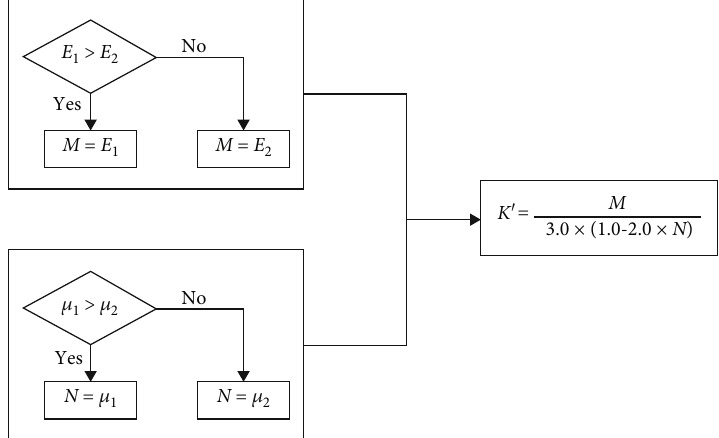
Figure 8: Logic relationship of the bulk modulus